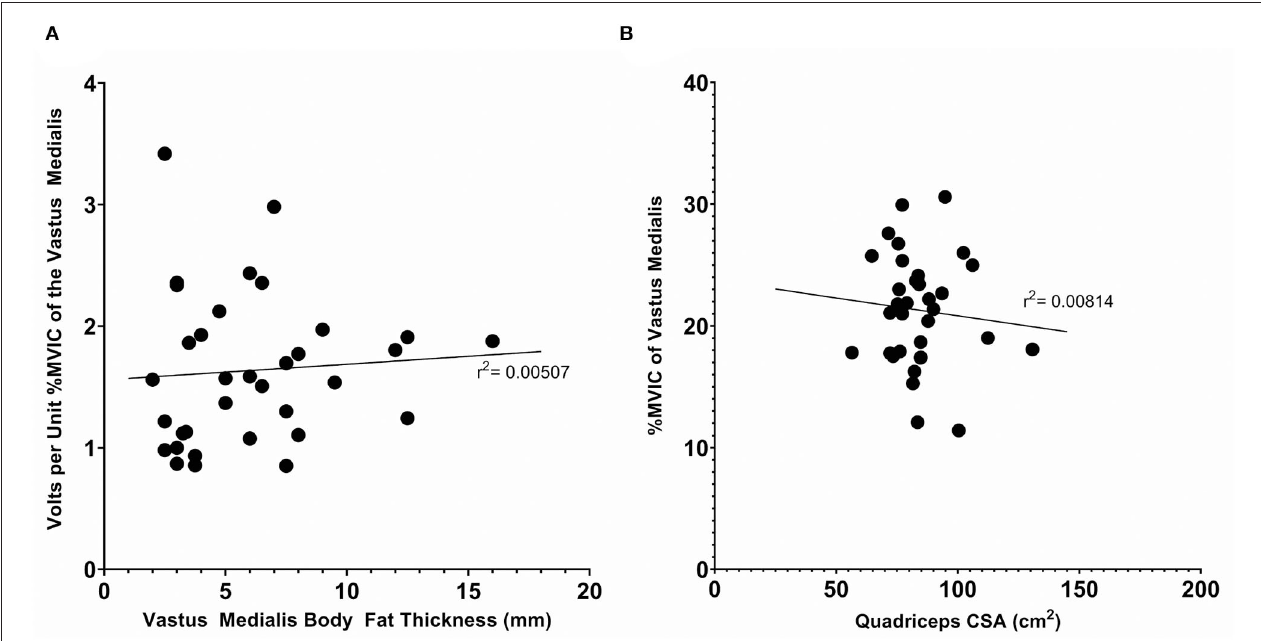
FIGURE 3 | Anthropometric measurements vs. calibration data for the complete subject set ( n = 34). (A) The subcutaneous body fat thickness, as measured with skinfold calipers, vs. the volts per unit %MVIC of the Vastus Medialis. (B) The quadriceps cross sectional area, as estimated with the mid-thigh circumference and distal thigh, subcutaneous body fat thickness, as measured with skinfold calipers, vs. the %MVIC of the Vastus Medialis achieved. Displayed r 2 values denote the coefficient of determination of a linear